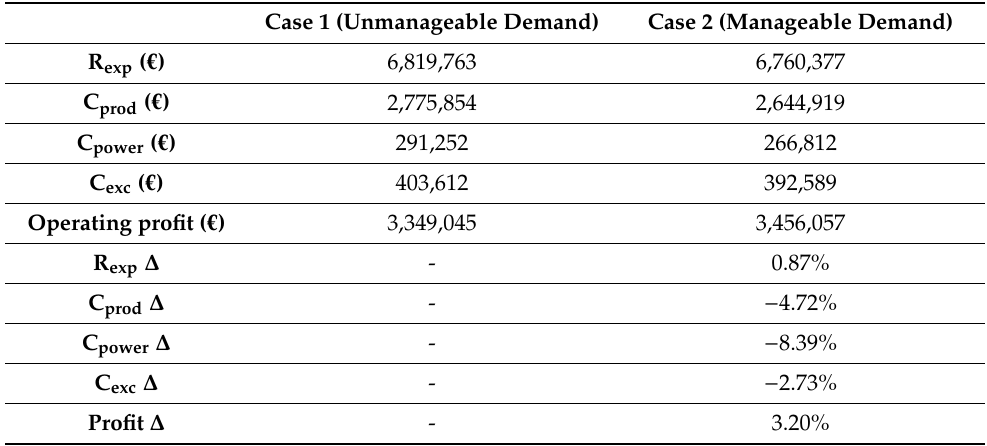
Table 8. Comparison of annual results of costs and income with and without intraday demand